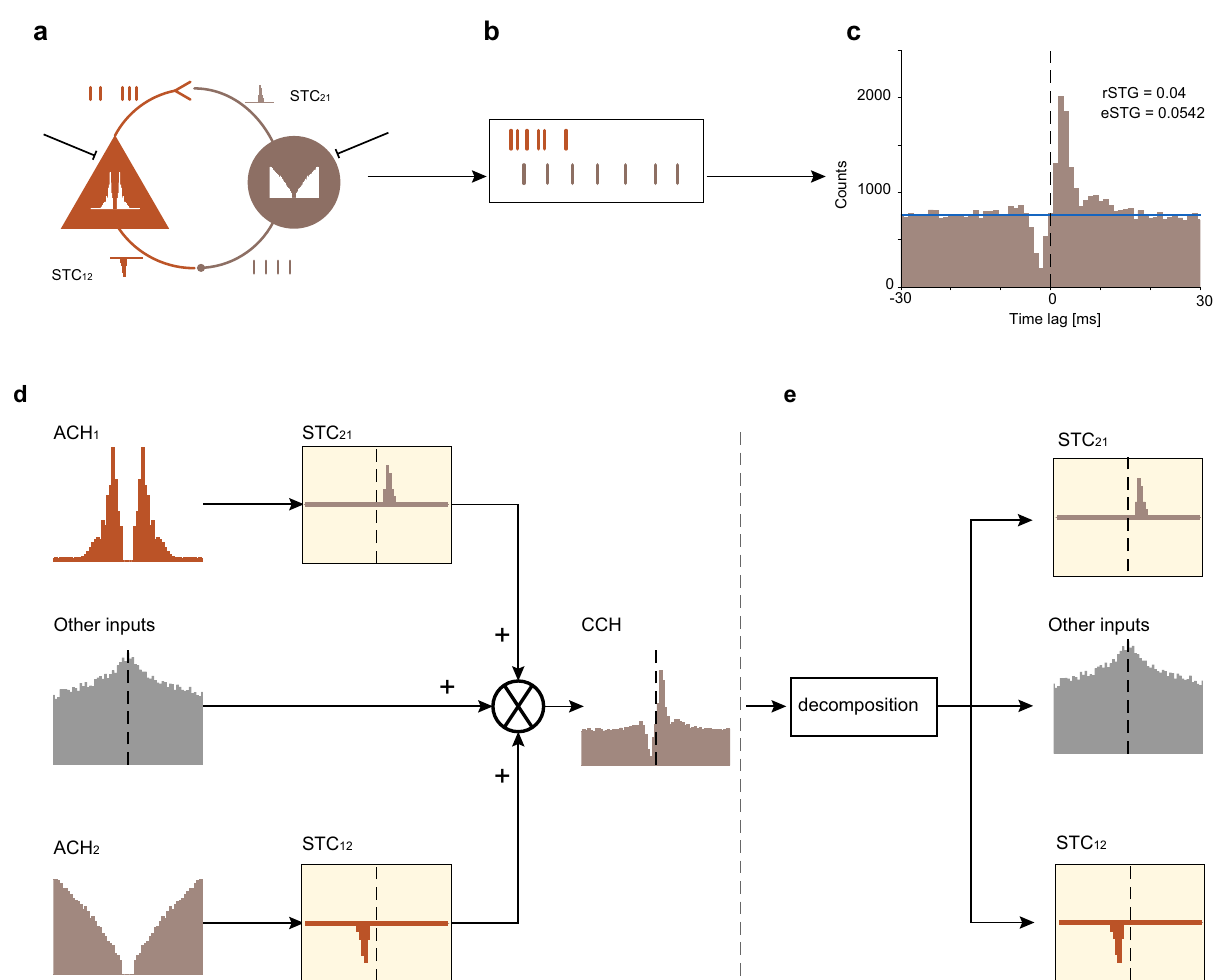
Fig. 2 The cross-correlation between two spike trains can be expressed as a sum of three elements. a Cartoon of two neurons, driven by external sources and coupled by reciprocal excitatory and inhibitory monosynaptic connections. In the example, both neurons exhibit spiking activity which deviates from a Poisson process: the excitatory neuron exhibits burst spiking, and the inhibitory neuron exhibits second-order gamma spiking activity. b The spike trains of the two neurons result from all of these (and possibly other) sources. c An example CCH created from the synthetic spike trains described in ( a , b ). The rSTG is 0.04, whereas the eSTG provides an inaccurate estimate (0.054; 135%). The example demonstrates that in the presence of complex dynamics, the STG cannot be estimated accurately by the “ tails ” method. d The CCH between two coupled spike trains, s 1 and s 2 , can be expressed as a sum of three elements. The fi rst element is the convolution of the auto-correlation histogram of the fi rst train (ACH 1 ) with the STC from neuron 1 to neuron 2 (STC 21 ). The second element, denoted as “ other inputs ” , is equal to the cross-correlation between the uncoupled spike trains. The third element is the convolution of ACH 2 with STC 12 . e Based on the composition ( d ), a decomposition procedure may recover the other inputs and the two STCs from the